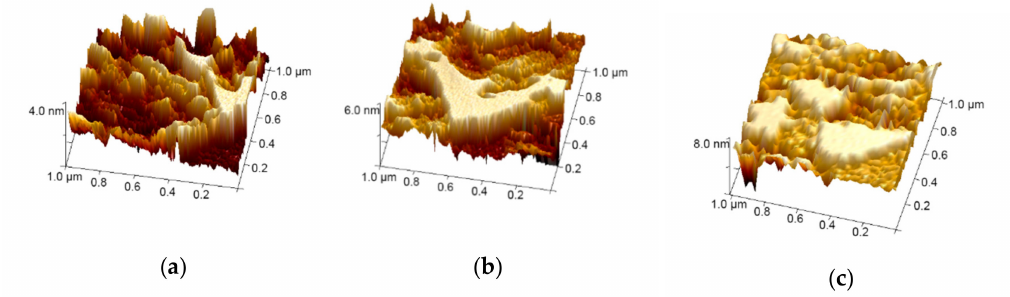
Figure 1. AFM images (1 µ m × 1 µ m) of the Cu layer with di ff erent thicknesses of ( a ) 4 nm, ( b ) 6 nm, and ( c ) 8 nm, deposited on the bottom